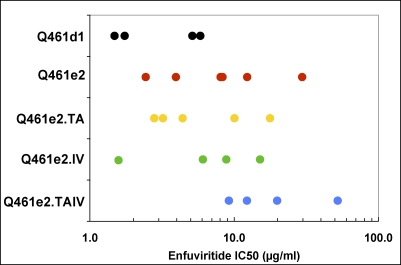
Infectivity and Susceptibility to Enfuviritide of Q461 Envelope VariantsIC50 values (in μg/ml) to enfuviritide of the pseudovirus indicated on the left are shown for each of five (Q461e2.TA, Q461e2.IV, Q461e2.TAIV) or six (Q461d1 and Q461e2) replicate experiments; in some cases points overlap. The Spearman rank test revealed no correlation between the mean enfuviritide concentration and mean susceptibility to any MAb or plasma sample (p > 0.8 for all comparisons).